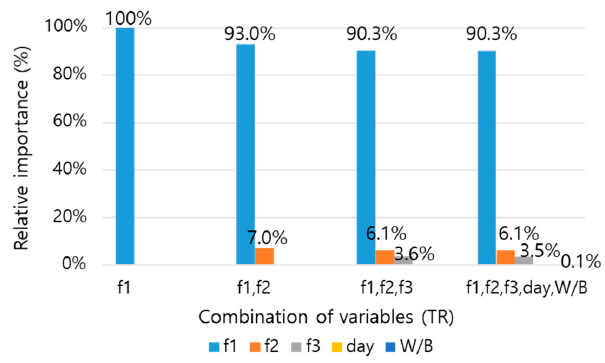
Figure 13. Relative importance according to combination of variables in TR mode.